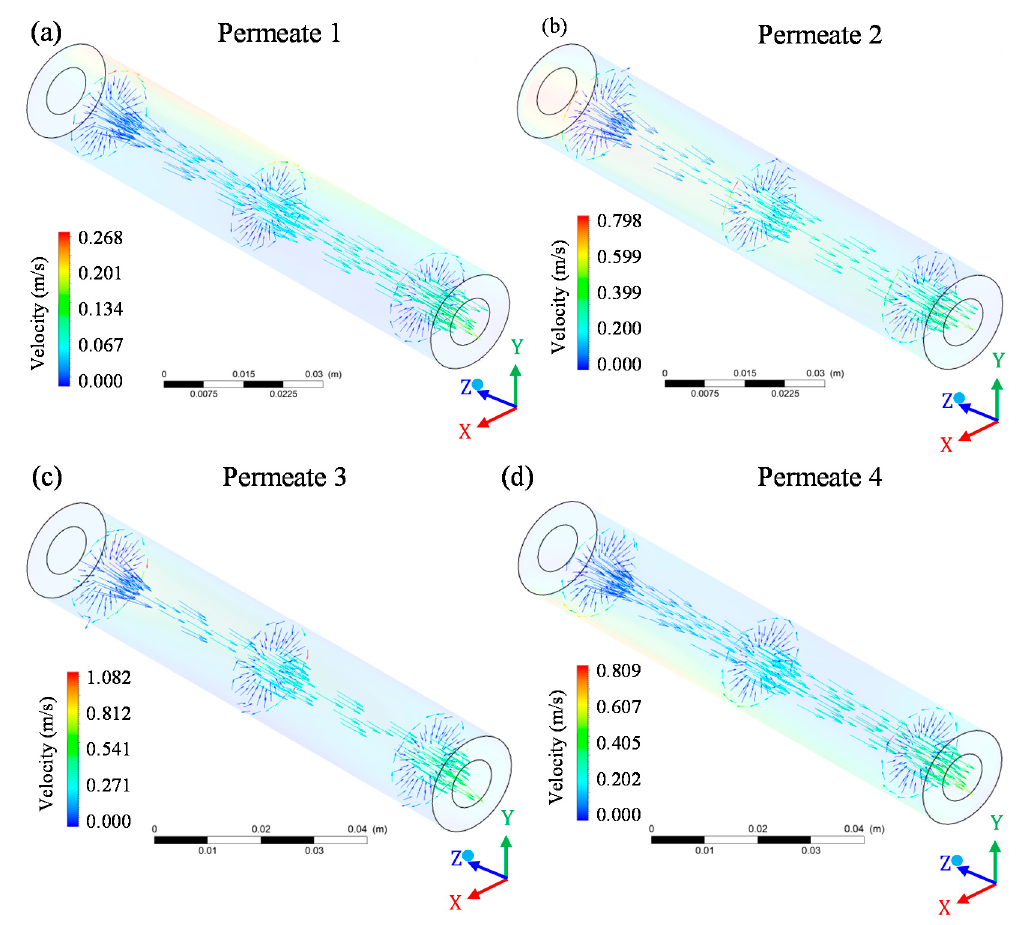
Figure 14. Vector velocity field of permeate in the four membranes of the filtration module during the water / oil separation process: ( a ) permeate 1; ( b ) permeate 2; ( c ) permeate 3 and ( d ) permeate 4. In the center of the permeate collecting tube (centroid of the x and y axes, − 0.015 and 0.015 m,